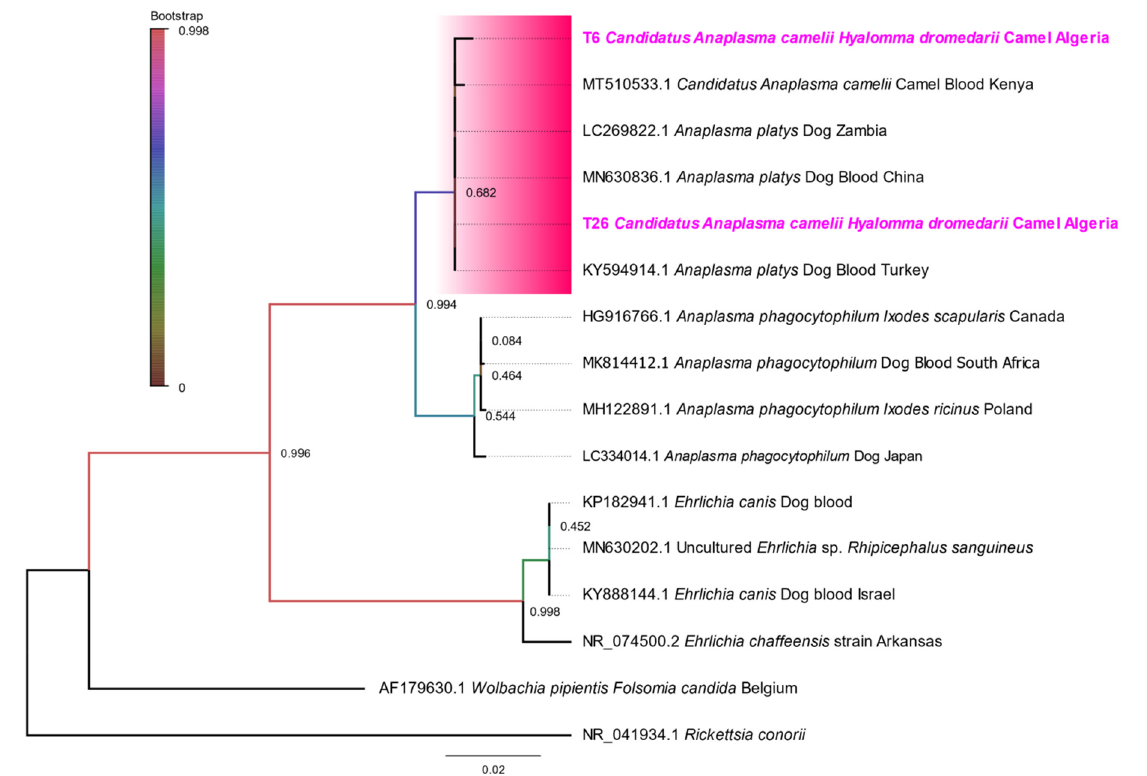
Figure 5. Representative maximum likelihood tree based on 16S rRNA sequences using Tamura 3-parameter model. Statistical support for internal branches of the trees was evaluated by bootstrap- ping with 500 iterations. The sequences obtained are highlighted in bold, and the cluster of Ca. A Camelii and A. platys is colored in rose. Rickettsia conorii was used as an outgroup.